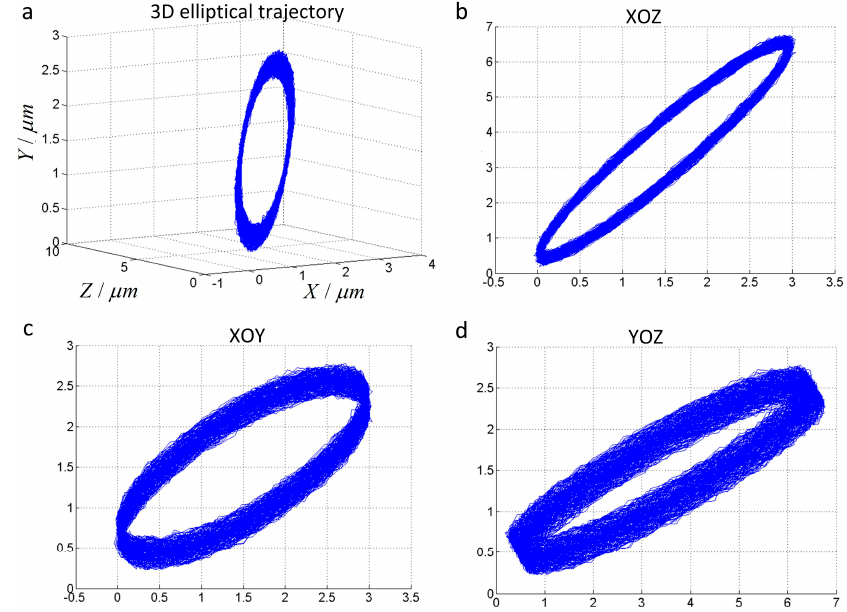
Figure 4. Tool trajectory of non-resonant three-dimensional elliptical vibration cutting (3D-EVC). A 1 = 7 μ m, A 2 = A 3 = 4 μ m, φ 1 = 0, φ 2 = π /2, φ 3 = π , ω 1 = ω 2 = ω 3 = 50 HZ. ( a ) The spatial elliptical trajectory; ( b ) The projection of the 3D elliptical trajectory in the XOZ plane; ( c ) The projection of 3D elliptical trajectory in the XOY plane; ( d ) The projection of the 3D elliptical trajectory in the YOZ plane.